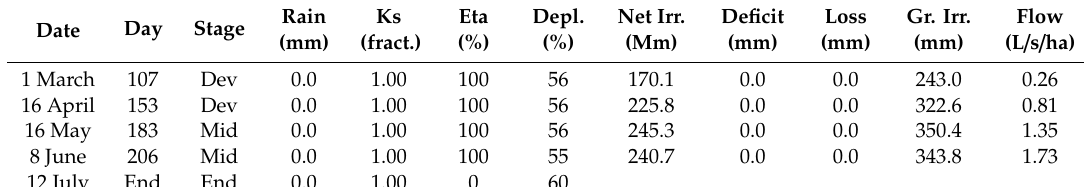
Table 7. Irrigation schedules for wheat.